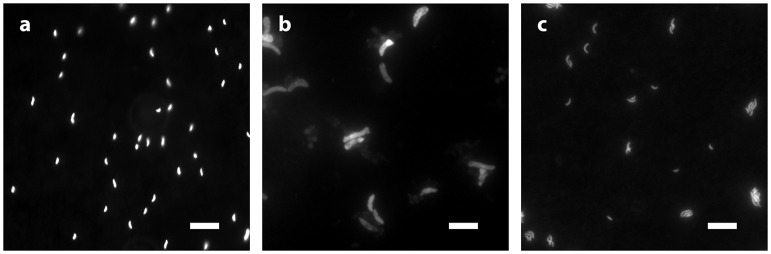
Morphology of species growing in phosphate-rich media and visualized by epifluorescence microscopy: (a)
D. fructosovorans (pyruvate, 2,200 μM PO43−, 6.1 days); (b)
D. inopinatus (malate, 1,500 μM PO43−, 27.8 days); and (c) DMSS-1 (lactate, 360 μM PO43−, 6.1 days). Scale bars in all panels represent 10 μm.